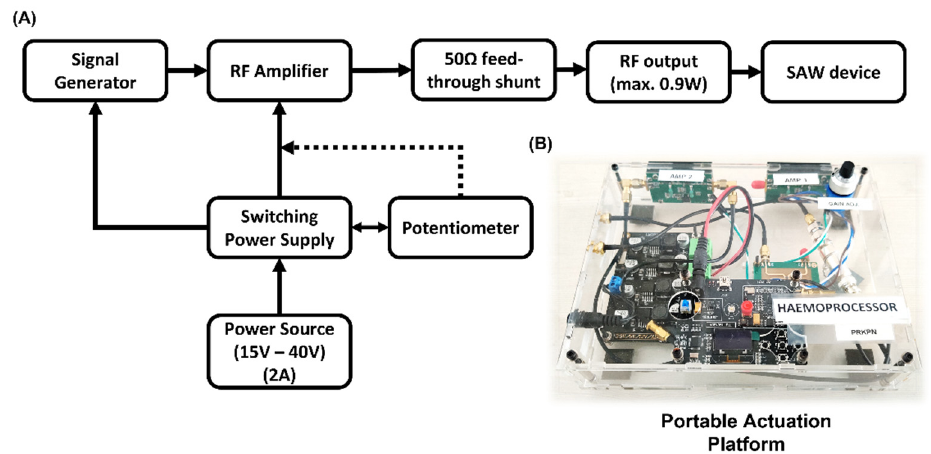
Figure 3. ( A ) The schematic for the portable actuation platform developed to be used with the Haemoprocessor chips. ( B ) The finished device weighs ca. 500 g and, as such, could easily be carried in a bag or a small briefcase. The use of the device was demonstrated in some of the particle and all the blood trials presented in this work. The performance of the platform is comparable to that of table-top generators with the additional advantage of portability.